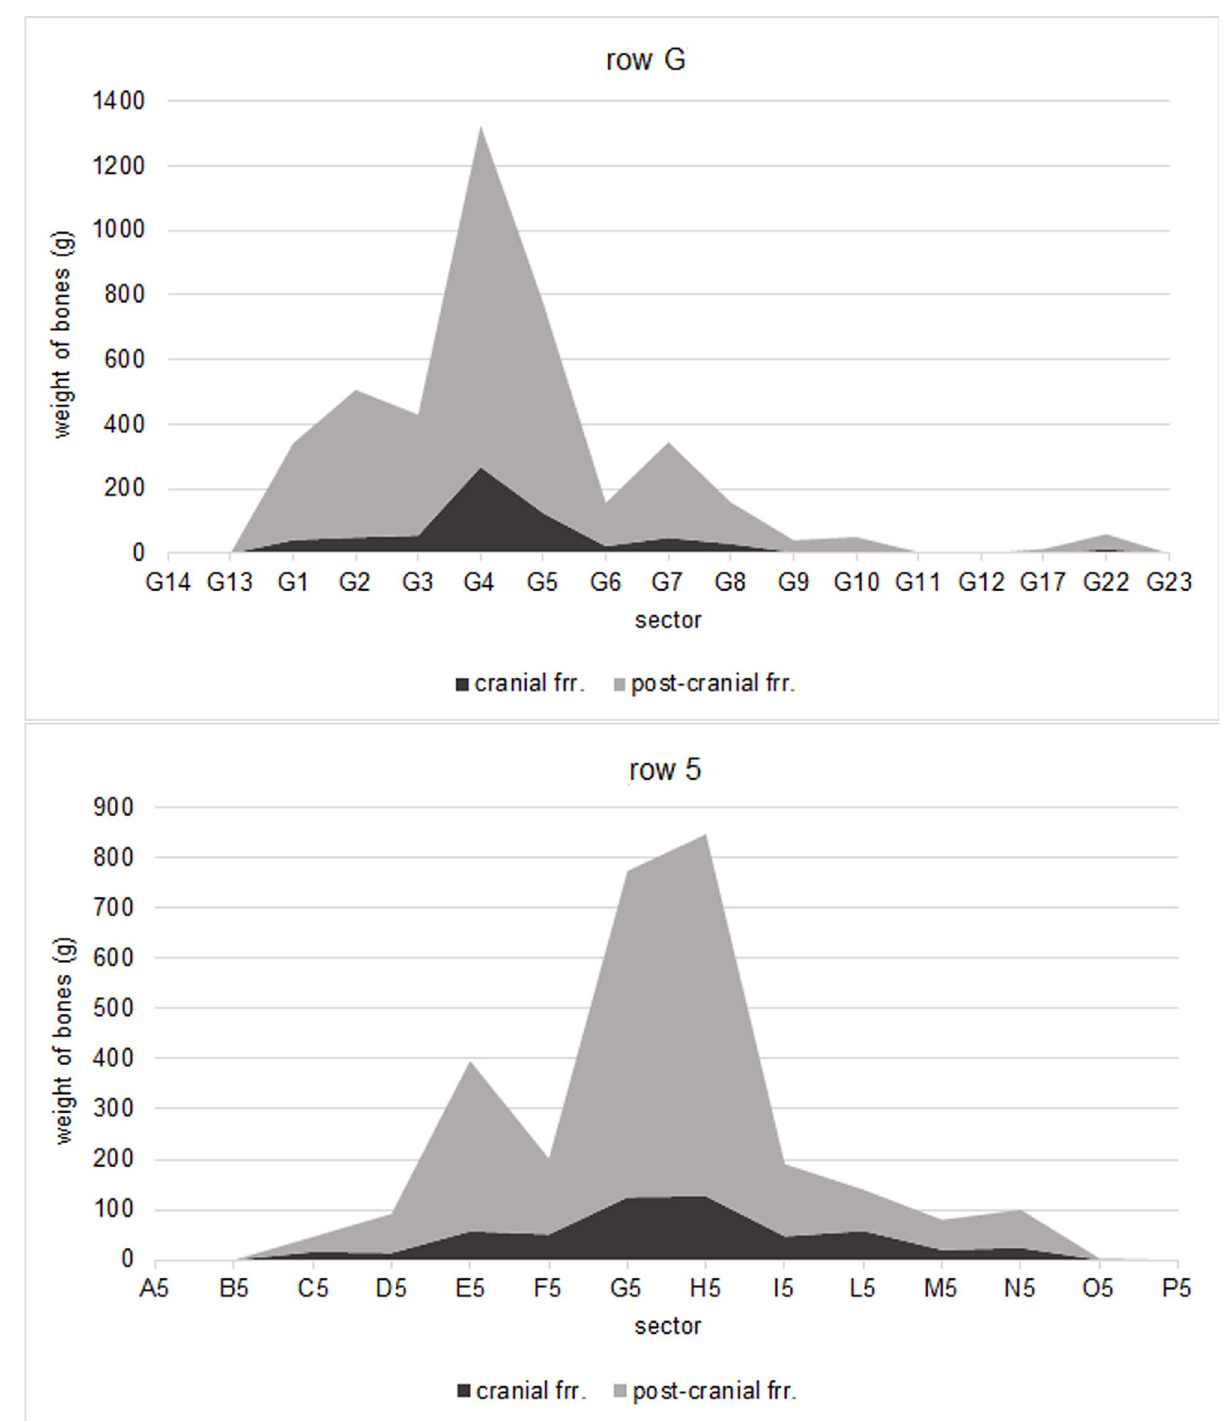
Fig 7. Weights of bone fragments represented across the transversal sections of the excavated area of 25x25 cm squares: Transect along row G (top) and east-west transect along row 5 (bottom).